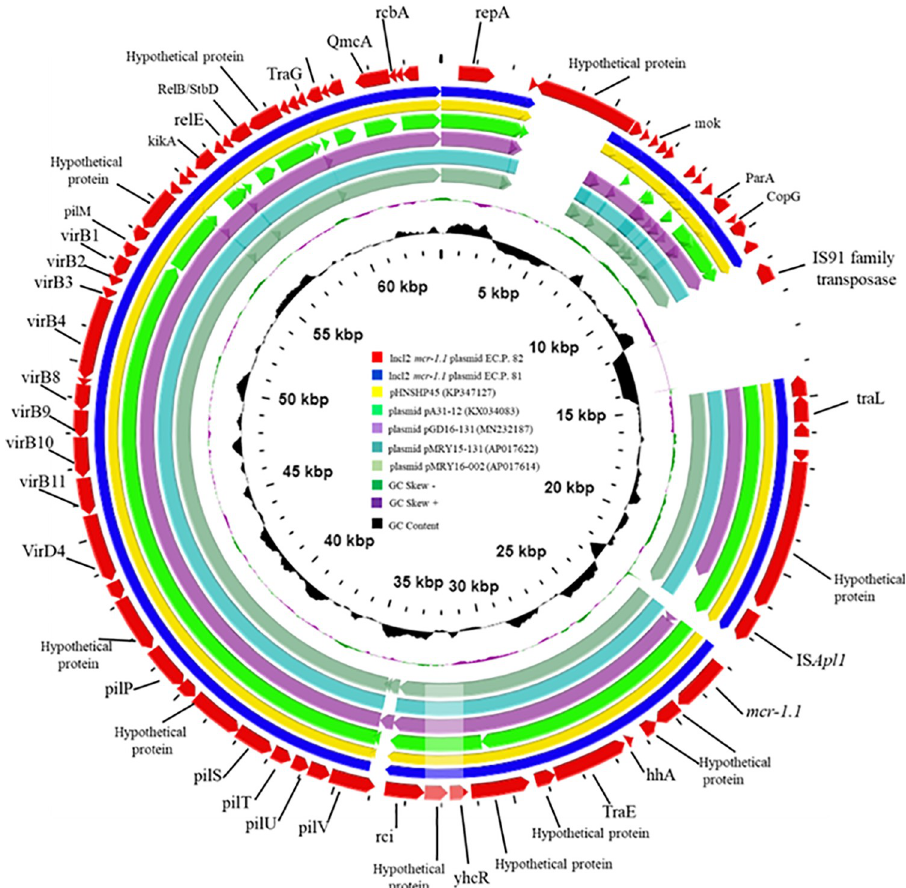
Fig 2. Circular comparison between mcr-1 . 1 -carrying IncI2 plasmids from ECP.81 and ECP.82 to five IncI2 type plasmids carrying mcr-1 with the highest similarity obtained from NCBI database. Circular comparison between mcr-1 . 1 -carryingIncI2 plasmids from ECP.81 and ECP.82 to five IncI2 type plasmids carrying mcr-1 with the highest similarity obtained from NCBI database (Accession No. KP347127, KX034083, MN232187, AP017622 and AP017614) generated by the Comparative Genomic tool (CG view) freely available at https://CGViewServer.ca. The outer-red circle denotes annotation of mcr-1 . 1 plasmids from the present study. The sequencing alignment indicates the high degree similarity of the mcr-1 . 1 harboring IncI2 plasmids from ECP.81 and ECP.82 to the mcr-1 -harboring plasmid, pHNSHP45, isolated in China. The insertions element, IS Apl1 is conserved in all mcr-1 -containing plasmids. Gaps indicate regions that were missing in the respective plasmid compared to the reference